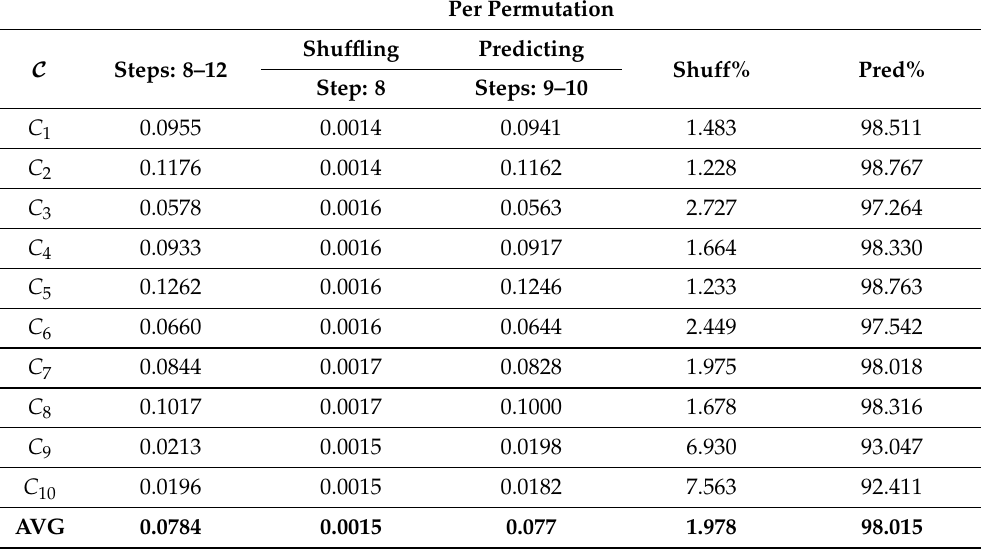
Table A4. The duration, in s, of each of the main steps of Algorithm 1 for each CNN. Per